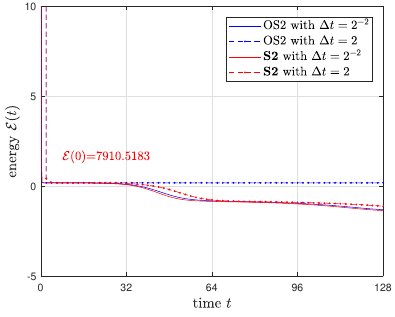
0.3420, respectively. −